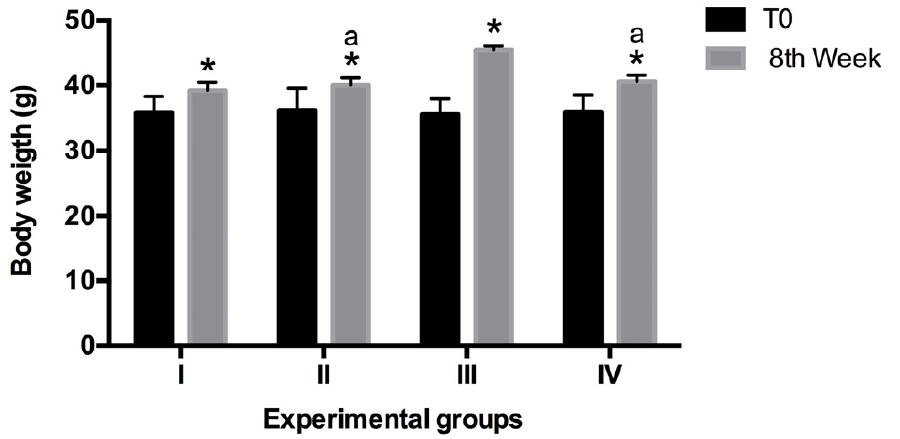
Figure 1. Weight of the mice per group. The weight at the beginning (Time 0) compared to the end of the experiment (8th week) was different. In group III (vanadium) the weight gain was higher than in the other groups. N = 10, values are expressed as the mean of body weight ± SEM in grams (ANOVA p ≤ 0.05 Tukey’s post hoc).* statistically significant differences vs. T0; a: statistically significant differences versus group III 8th week.